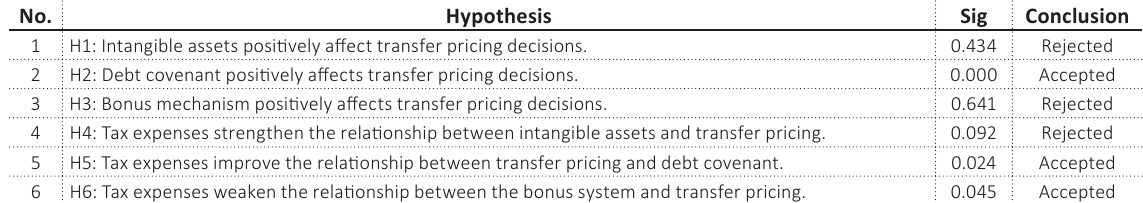
Table 5. Hypotheses testing